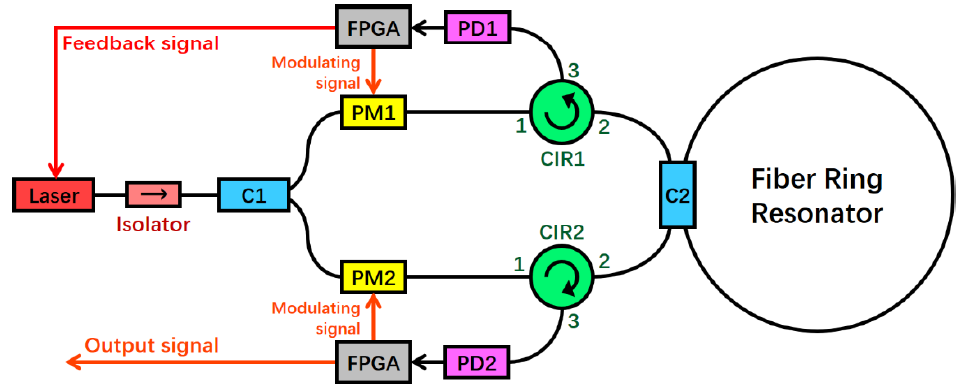
Figure 1. System structure of RFOG. (FPGA: field-programmable gate array, PD: photodiode, PM: phase modulator, C: coupler, and CIR: circulator).